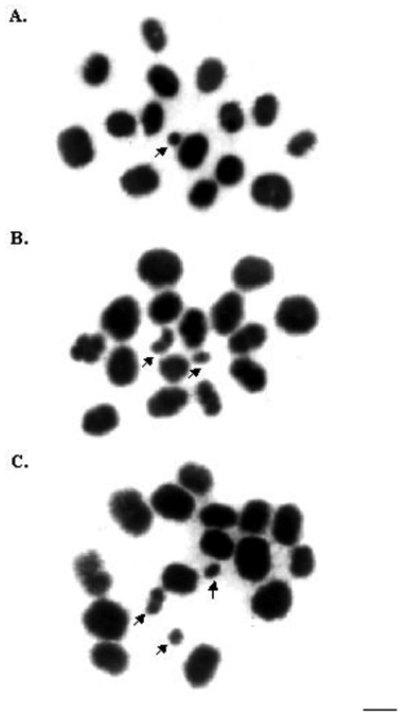
Figure 2 - D. nanus metaphases I with 15 bivalents and one (A), two (B) and three (C) small univalent B-chromosomes, after Giemsa staining. Bar = 5 µ